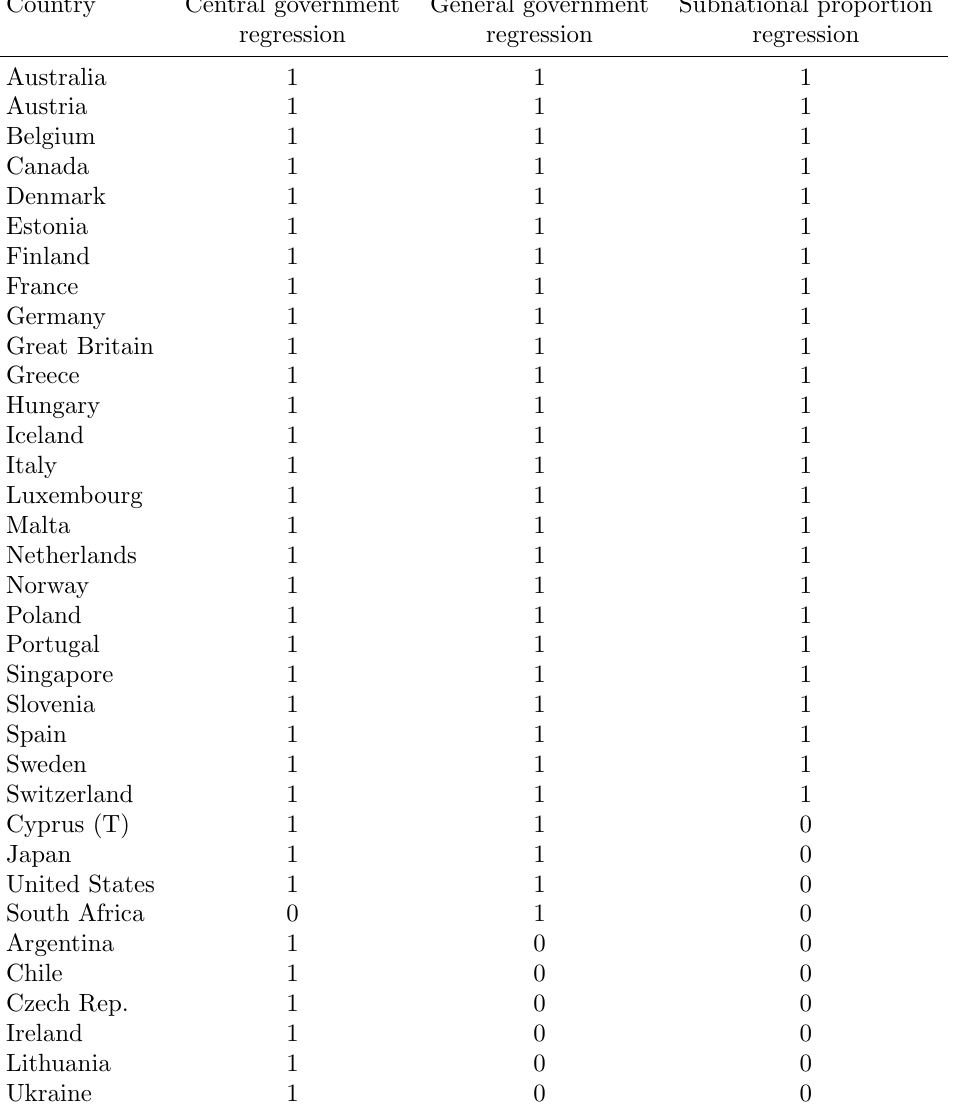
Table A.4: List of countries included in regressions Country Central government General government Subnational proportion regression regression